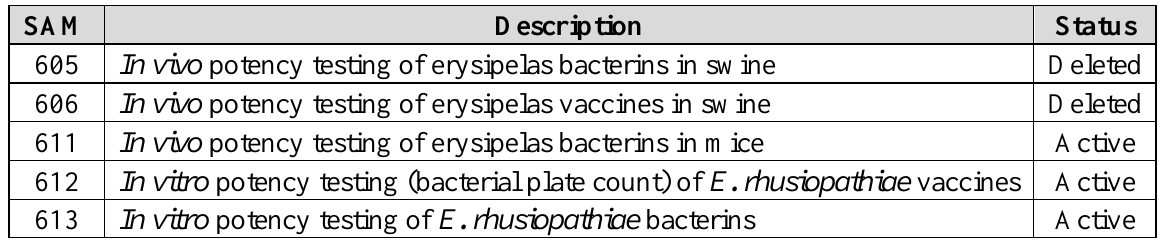
Table 1. Status of USDA Supplemental Assay Methods for E. rhusiopathiae biological